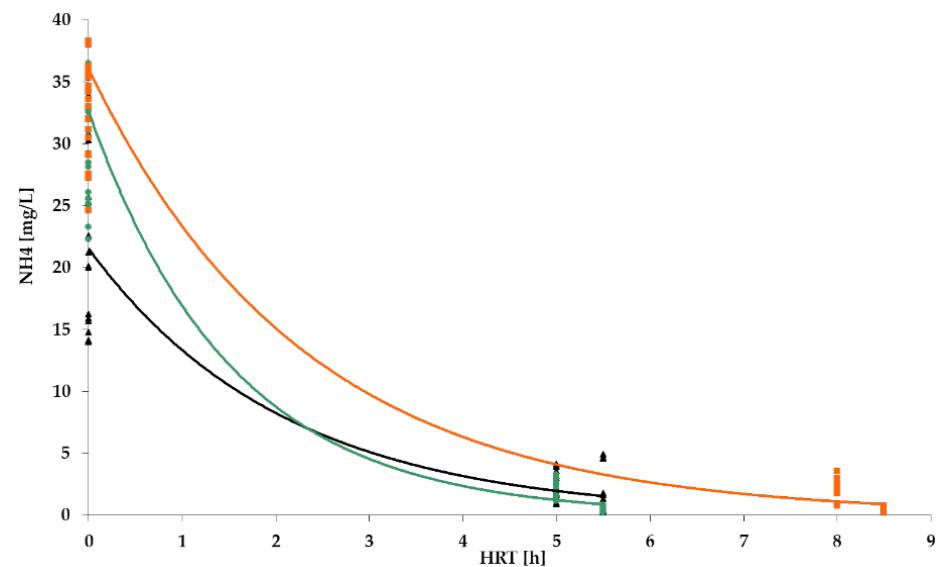
Figure 18. BOD 5 removal dynamics: stage 1 (black); stage 2 (green); stage 3 (orange).